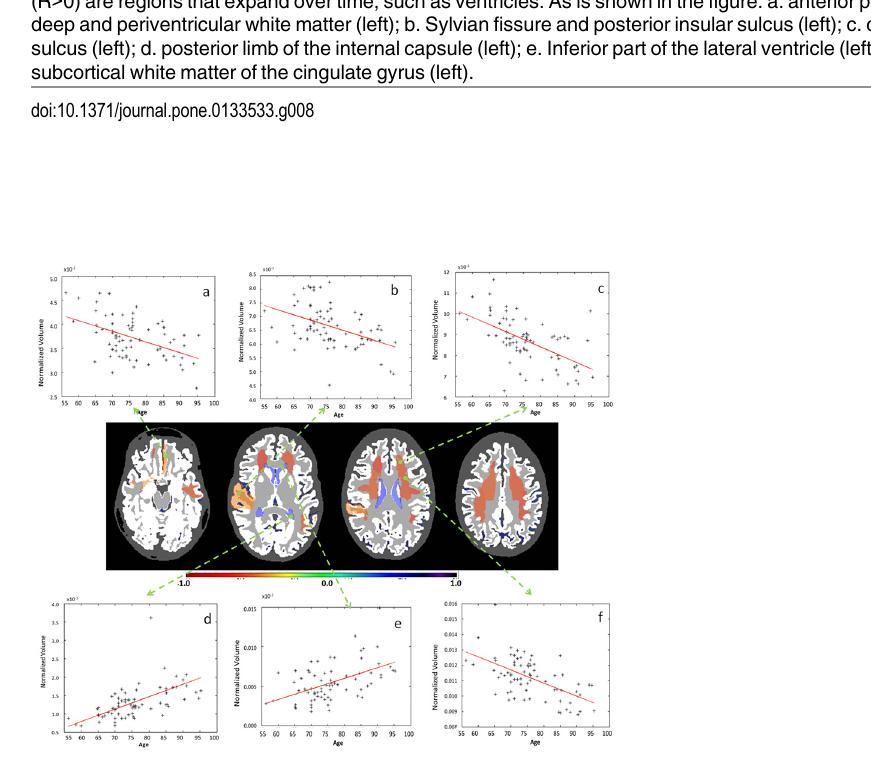
Fig 9. Examples of significant correlations between regional volumes and age at granularity level 5. The colors code the correlation coefficient R in regions where the age vs. volume curve achieves significance (p-value < 0.05, Bonferroni-corrected). Yellow / orange / red (R < 0) are regions that shrink over time, while blue (R > 0) are regions that expand over time, such as ventricles. As is shown in the figure: a. gryus rectus (left); b. subcortical white matter of the superior temporal gyrus (right); c. anterior corona radiata (left); d. inferior horn of the lateral ventricle (left); e. frontal horn of the lateral ventricle (left); superior corona radiata (left).